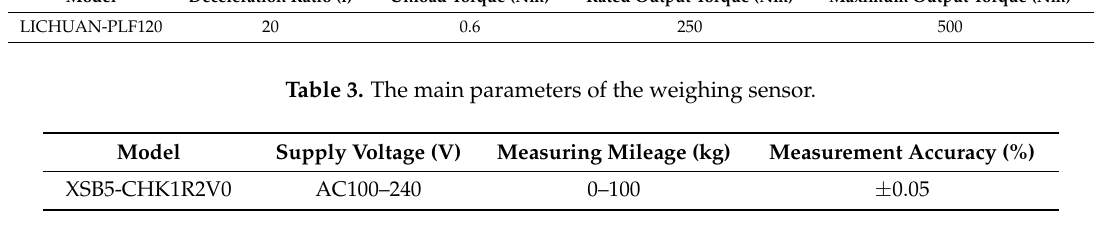
Table 4. The main parameters of the angular velocity